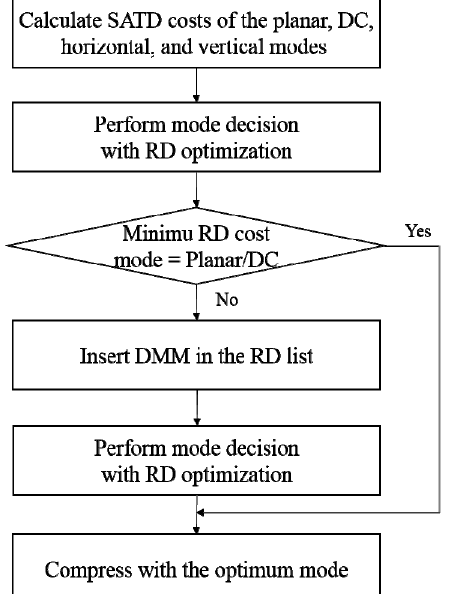
Figure 3. Flowchart of the fast conventional HEVC intra mode decision and adaptive depth modeling mode (DMM) search method (FHEVCI+ADMMS) for the fast depth intra mode decision.